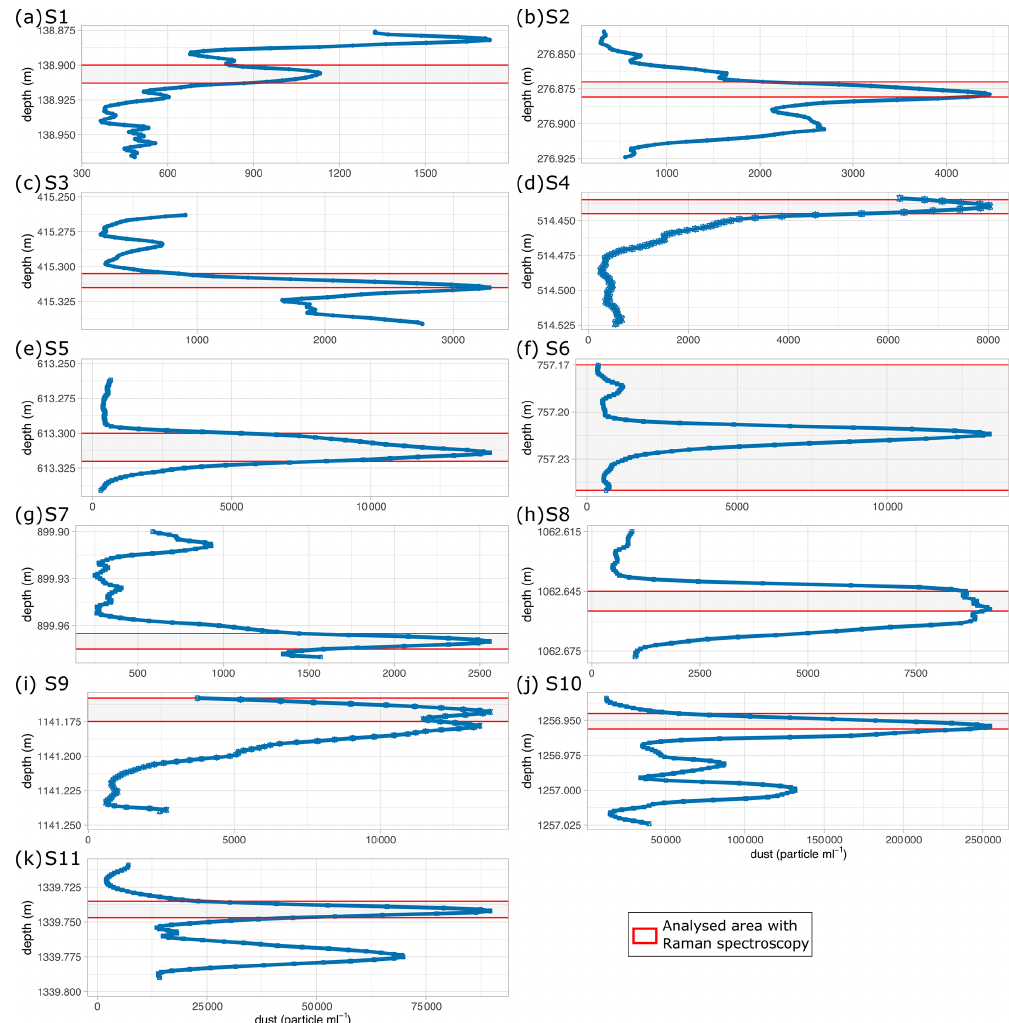
Figure 2. Number counts of insoluble particles larger than 1µmmL − 1 (dust) derived via CFA from the chosen depths analysed with Raman spectroscopy. Please note the different scales in dust concentration on the abscissa. S10 is within a cloudy band, a horizontal layer of much higher dust content than the area above and